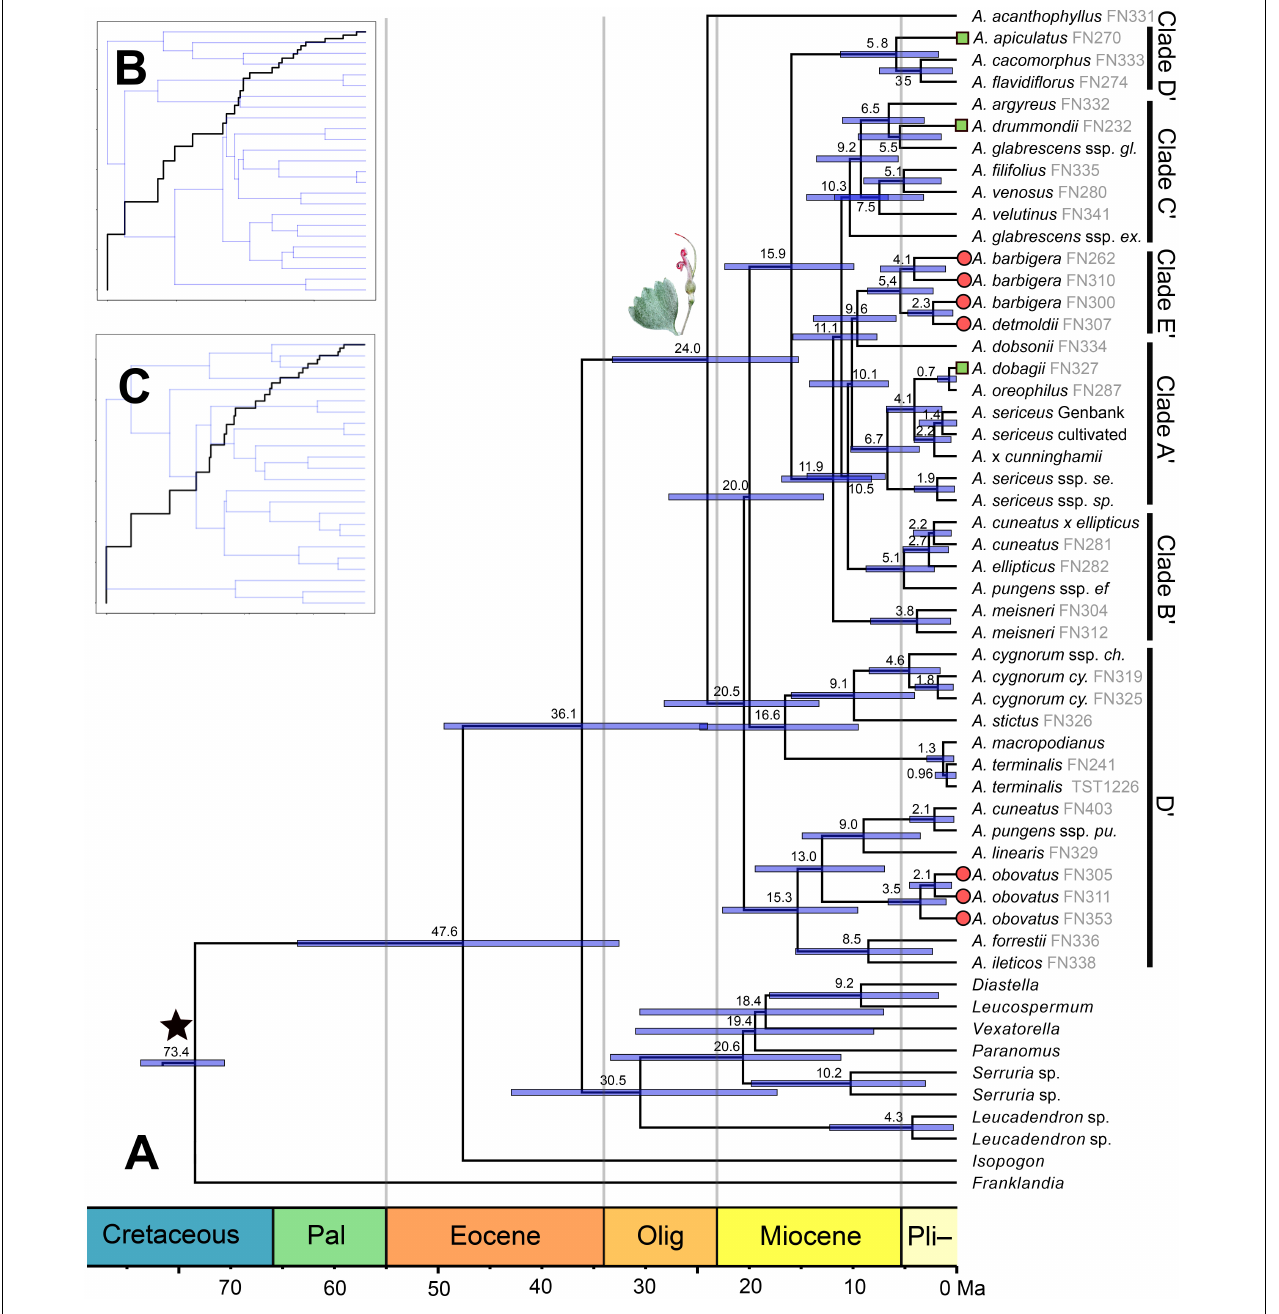
FIGURE 4 | (A) Calibrated BEAST chronogram of Adenanthos inferred from 13 chloroplast markers, with branch lengths scaled according to time (Ma). Non-Proteoideae outgroups used in the family-wide calibration scheme were pruned. Divergence times (Ma) are given at each node, with 95% confidence intervals indicated as blue bars. Clade labels denote the clades from the plastid ML RAxML tree. Adenanthos stictus illustration denotes the crown of the genus. Star denotes the fossil calibration used in Proteoideae ( Franklandia ). Subspecies are abbreviated by the first two letters of the epithet. (B) Lineage-through-time plot of Adenanthos based on the BEAST plastid topology. (C) Lineage-through-time plot of Adenanthos based on the BEAST ITS nuclear